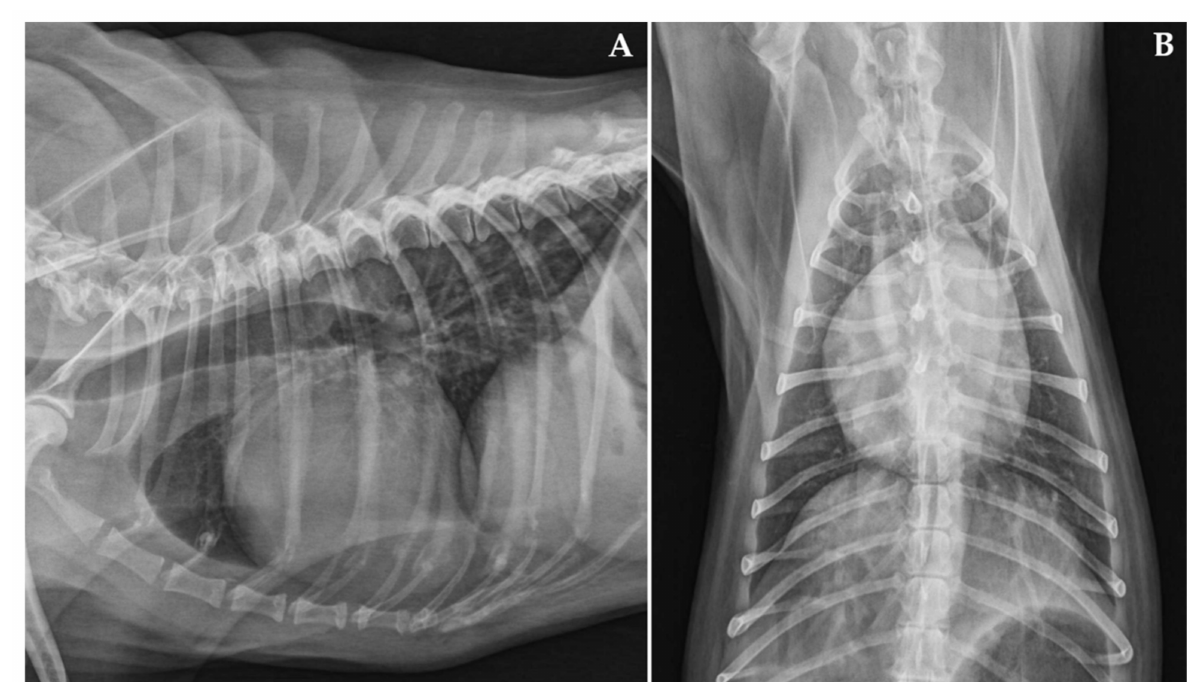
Figure 1. Right lateral ( A ) and dorso-ventral ( B ) radiographs of the thorax. Mild enlargement of the cardiac silhouette with no lung parenchymal abnormalities is evident.